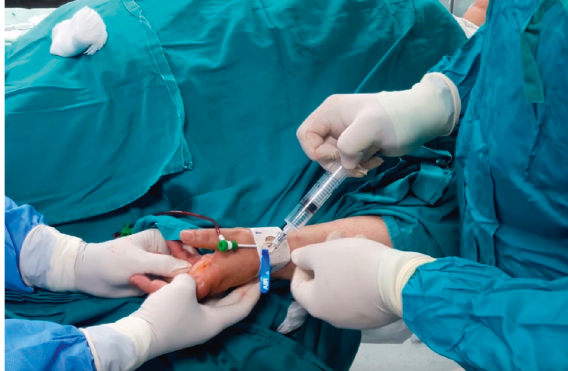
Figure 2: Hemostatic device is inflated before complete removal of the